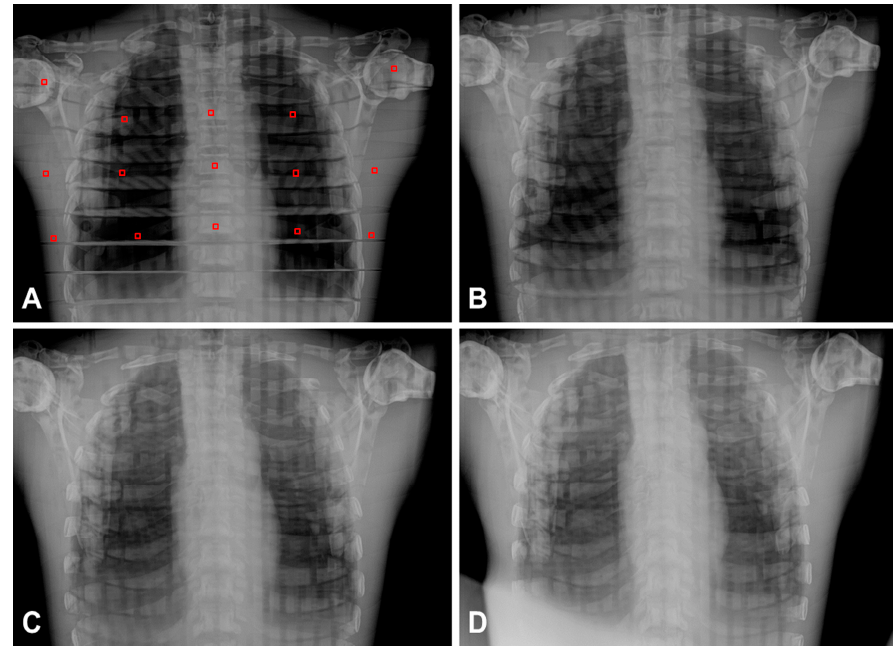
Figure 6. Representative chest AP images obtained from the developed PDR according to different angles: ( A ) 0° (=perpendicular); ( B ) 10°; ( C ) 20° and ( D ) 30° angle degree. The squares of red line (30 × 30 pixels) on AP image indicated 15 points for SNR and CNR measurements.